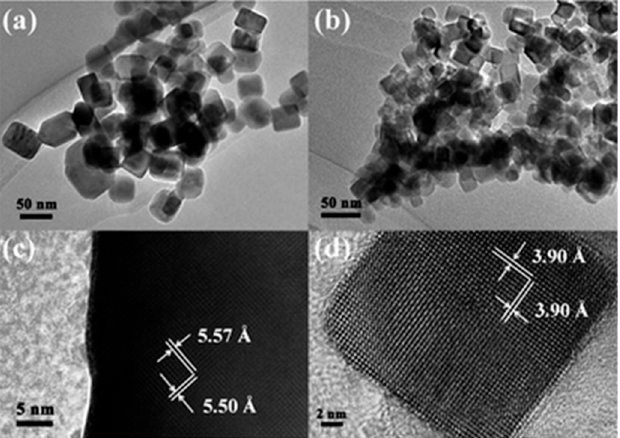
Figure 14. TEM images of ( a ) NaNbO 3 –cubic and ( b ) NaNbO 3 –orthorhombic. HR-TEM images of ( c